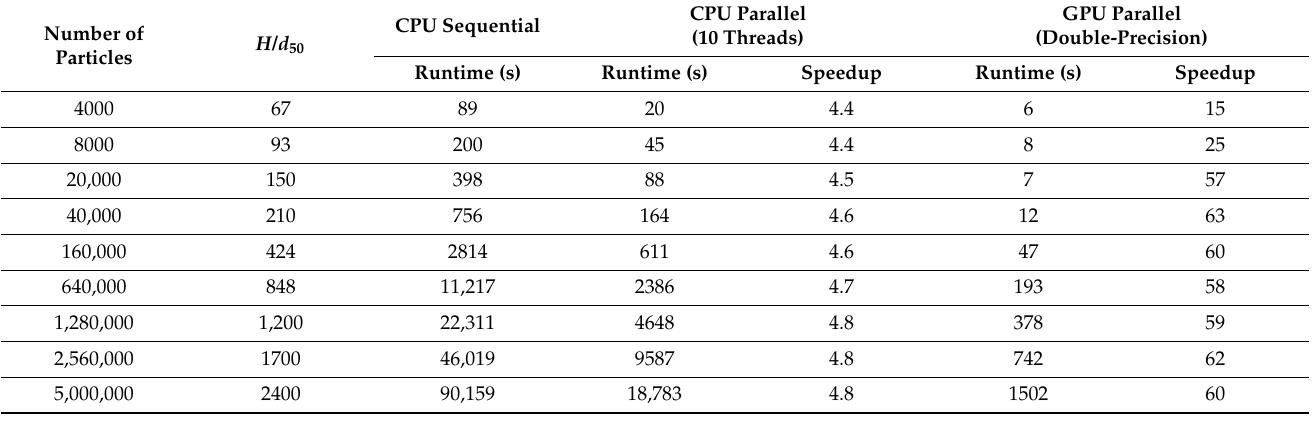
Figure 15. Speedups with different model sizes for dam break runouts. Table 4. Speedups of CPU and GPU parallel simulations in dam break cases (10,000 incremental steps).